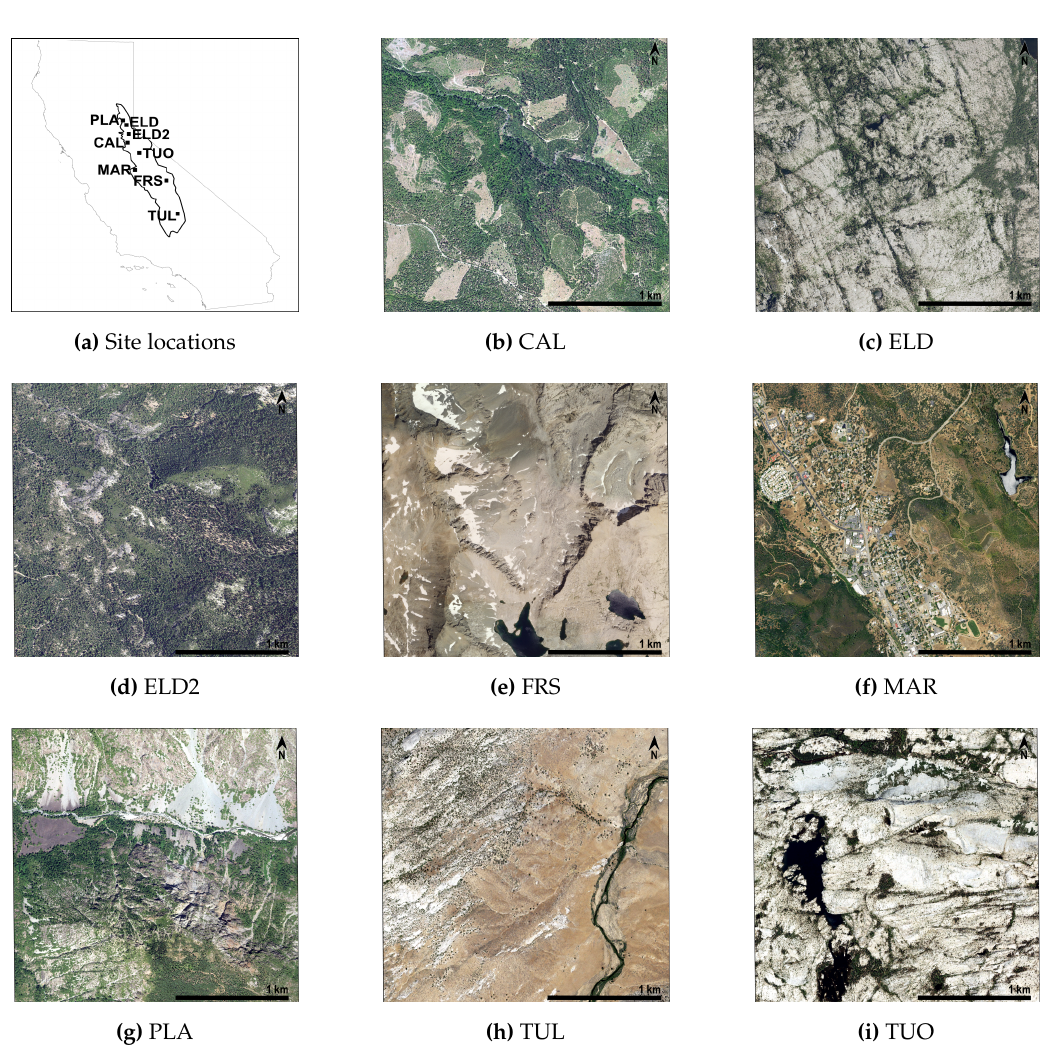
Figure 3. Locations of each 2.5 × 2.5 km test site ( a ) and 2016 NAIP Imagery used for each site ( b – i